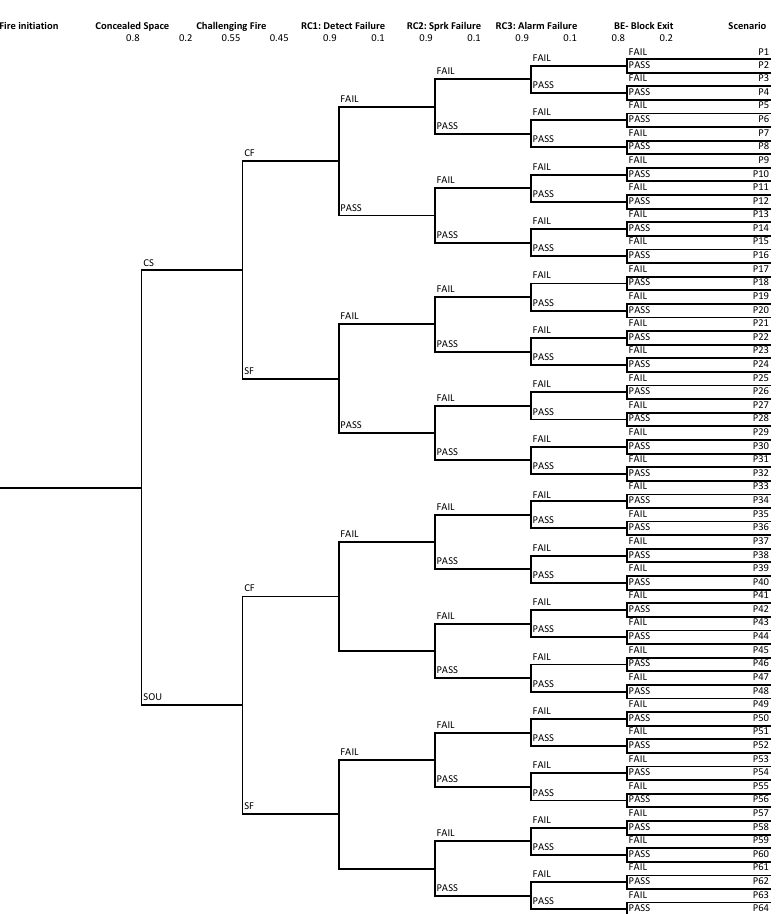
Figure 6. Typical Event Tree—apartment fire.